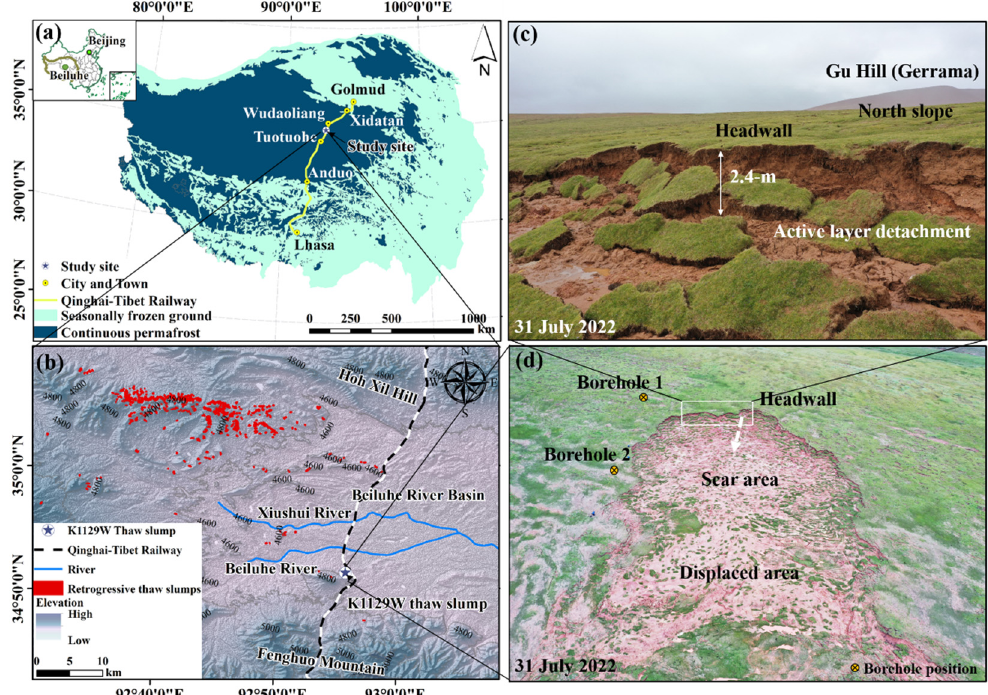
Figure 1. Location of the study area on the Qinghai–Tibet Plateau (QTP). ( a ) The distribution of permafrost on the QTP; the data [24] are from the Qinghai–Tibet Plateau Science Data Centre for China, National Science and Technology Infrastructure (https://data.tpdc.ac.cn, accessed on 20 April 2021); ( b ) the topographic map of the study area (modified from [10]); ( c ) the details of the studied thaw slump; and ( d ) the K1129W thaw slump developed on the northeast slope of the Gerlama Hill in the Beiluhe River Basin. Note that the thaw slump development direction and borehole location information are shown in Figure 1d.